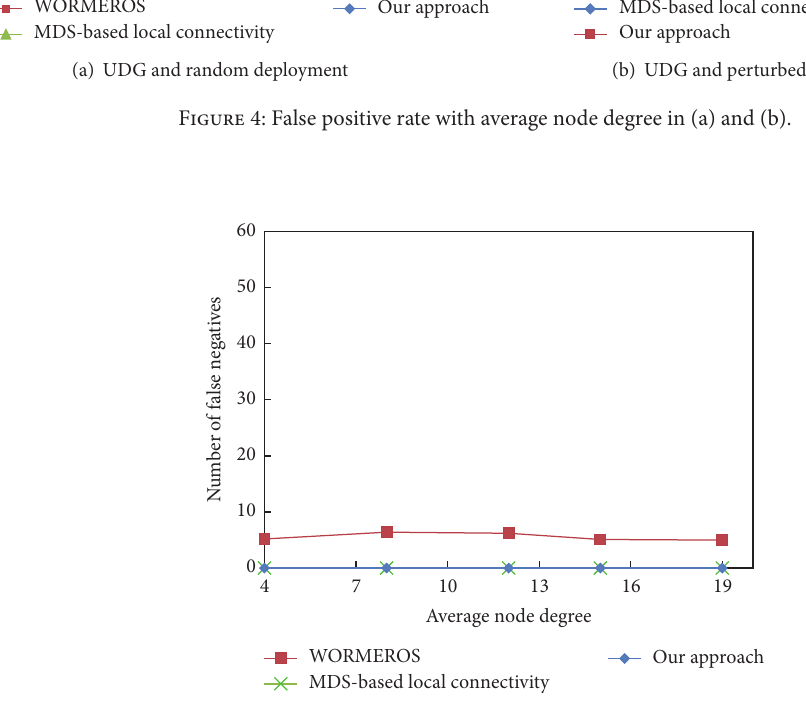
Figure 5: False negative rate with average node degree in UDG model with random deployment.